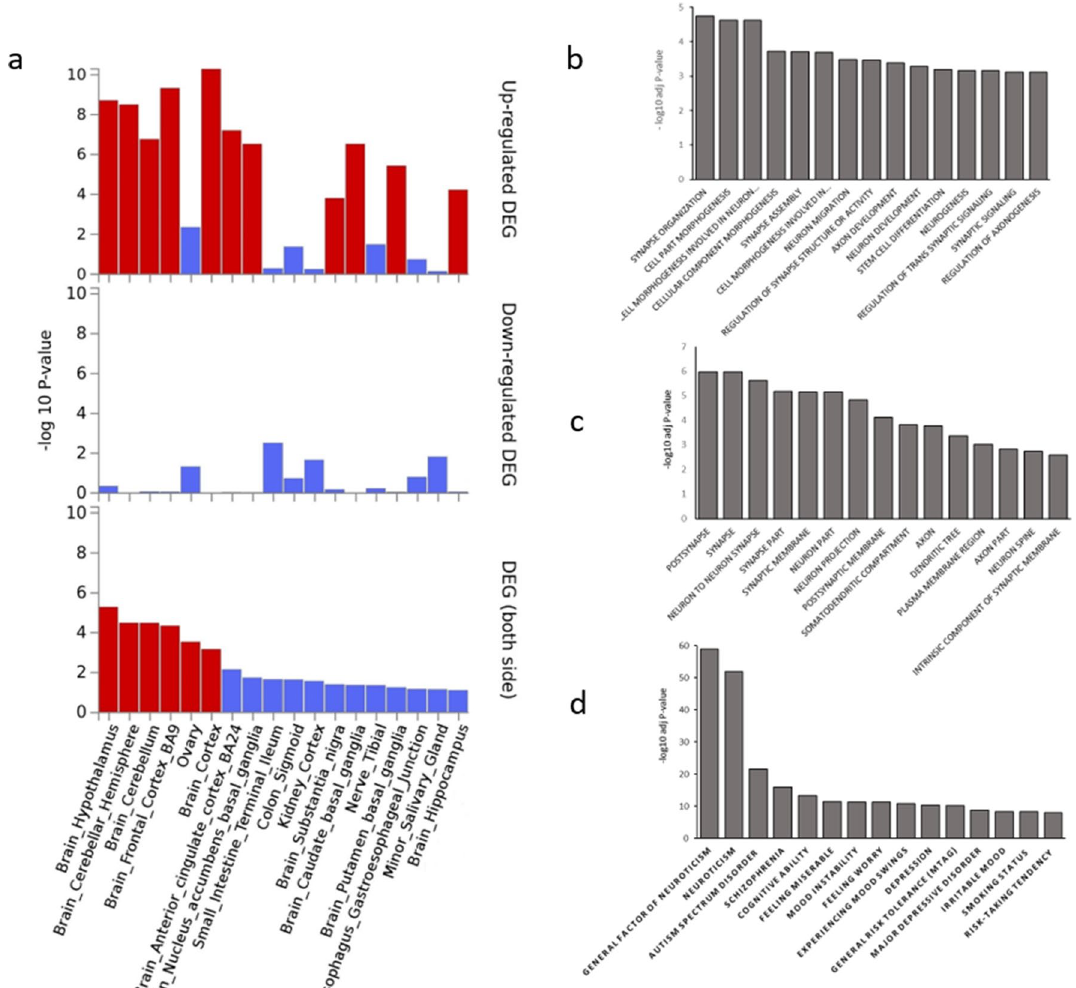
Figure 3. Enrichment of 190 genes identified by gene-based association analysis in different gene sets. ( a ) Tissue enrichment for differential expression. ( b ) Enrichment in GO biological processes. ( c ) Enrichment in GO cell components. ( d ) Representation of genes in the GWAS